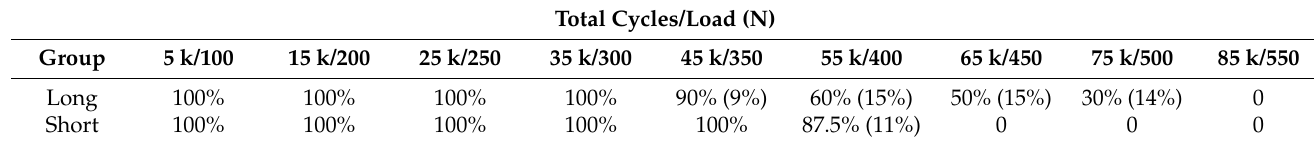
Table 5. Probability of survival of experimental groups according to applied load and number of steps (cycles).